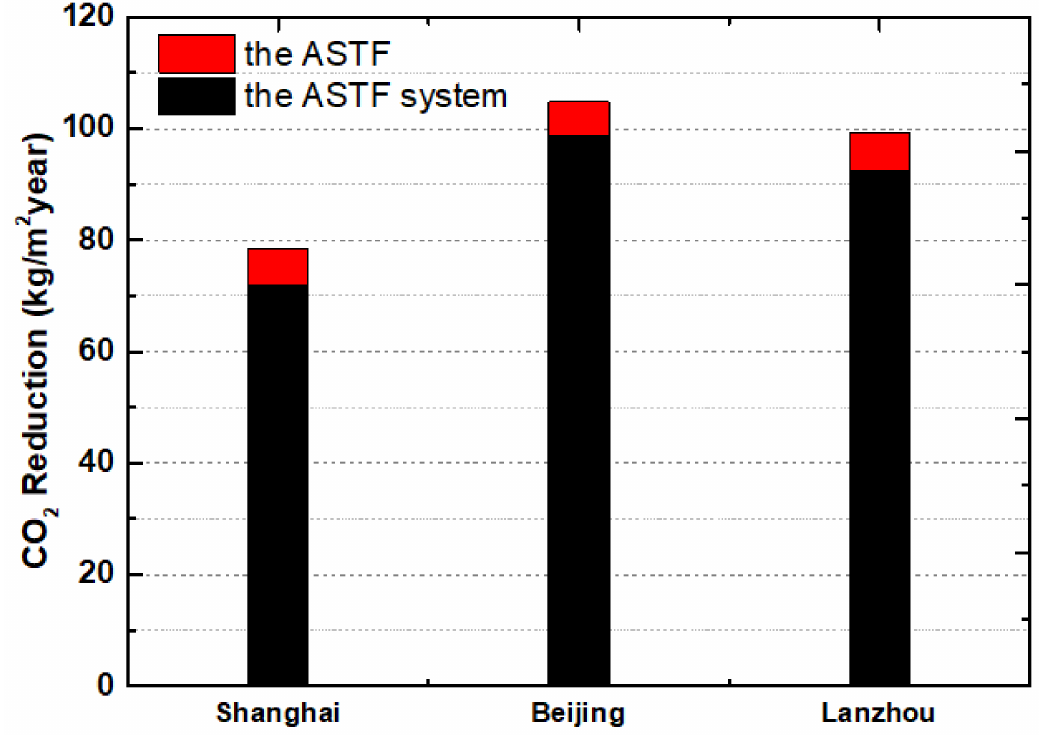
Figure 12. Annual CO 2 emission